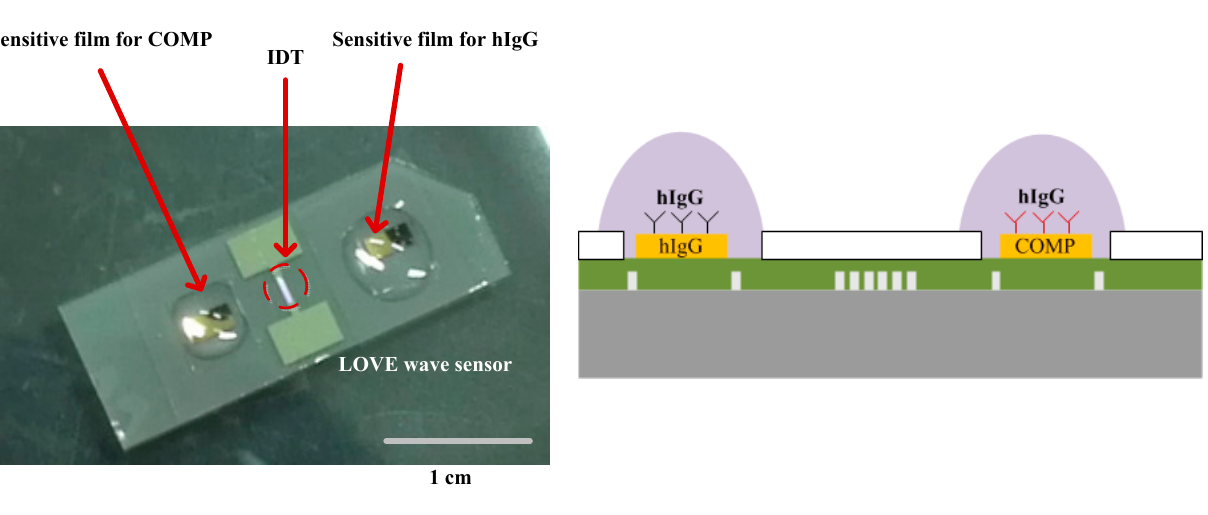
Figure 10. Exact amount of target biosolution was dispensed out of pipette onto opened windows surround by PDMS